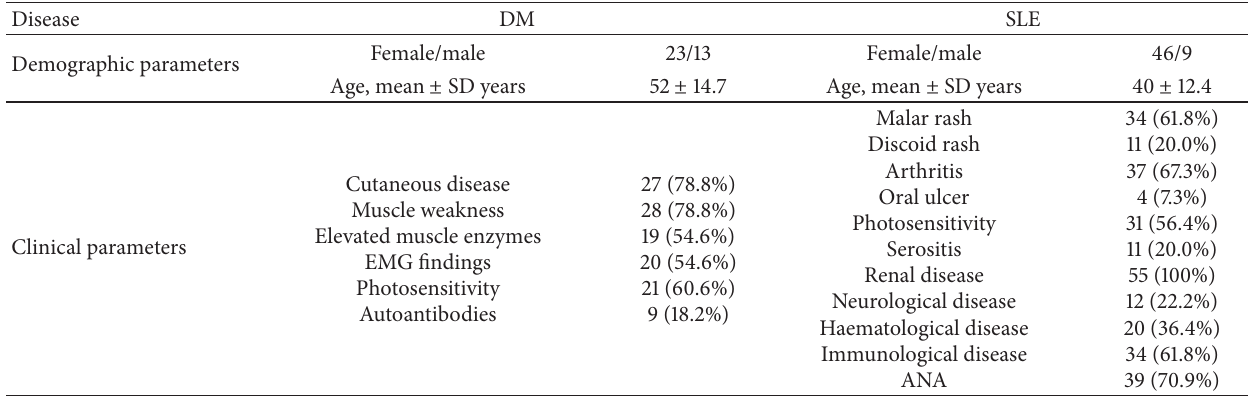
Table 1: Demographic and clinical